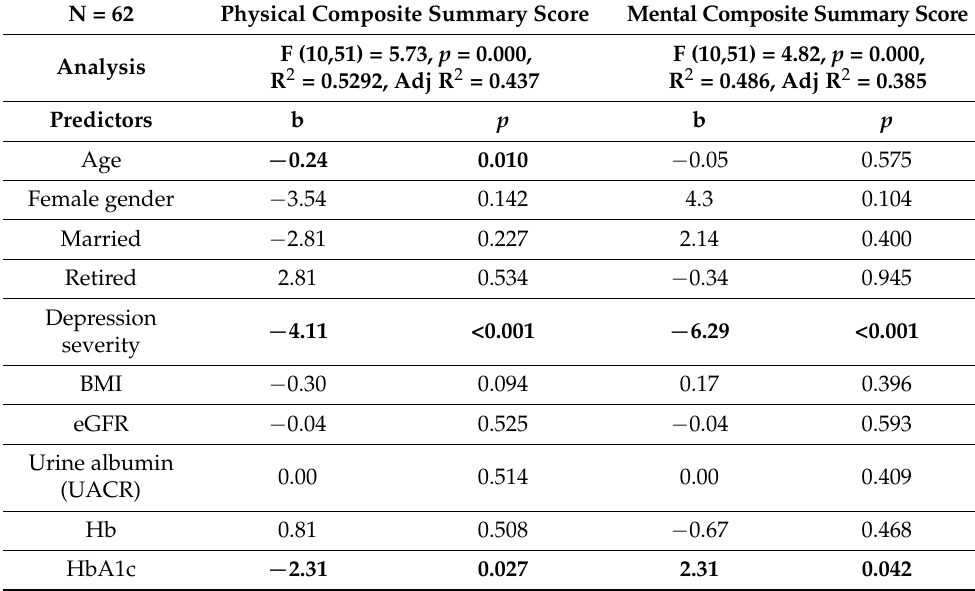
Table 6. Predictors of health-related quality of